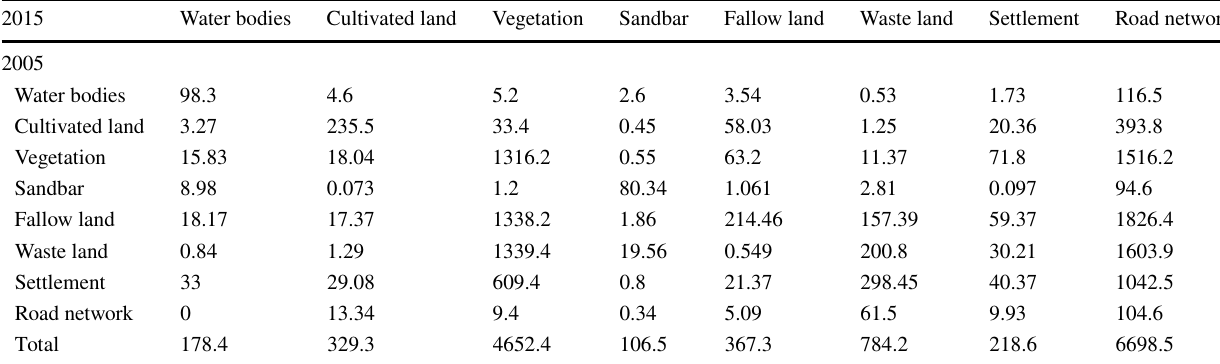
Table 4 The transition matrix from 2005 to 2015 (area in km 2 )